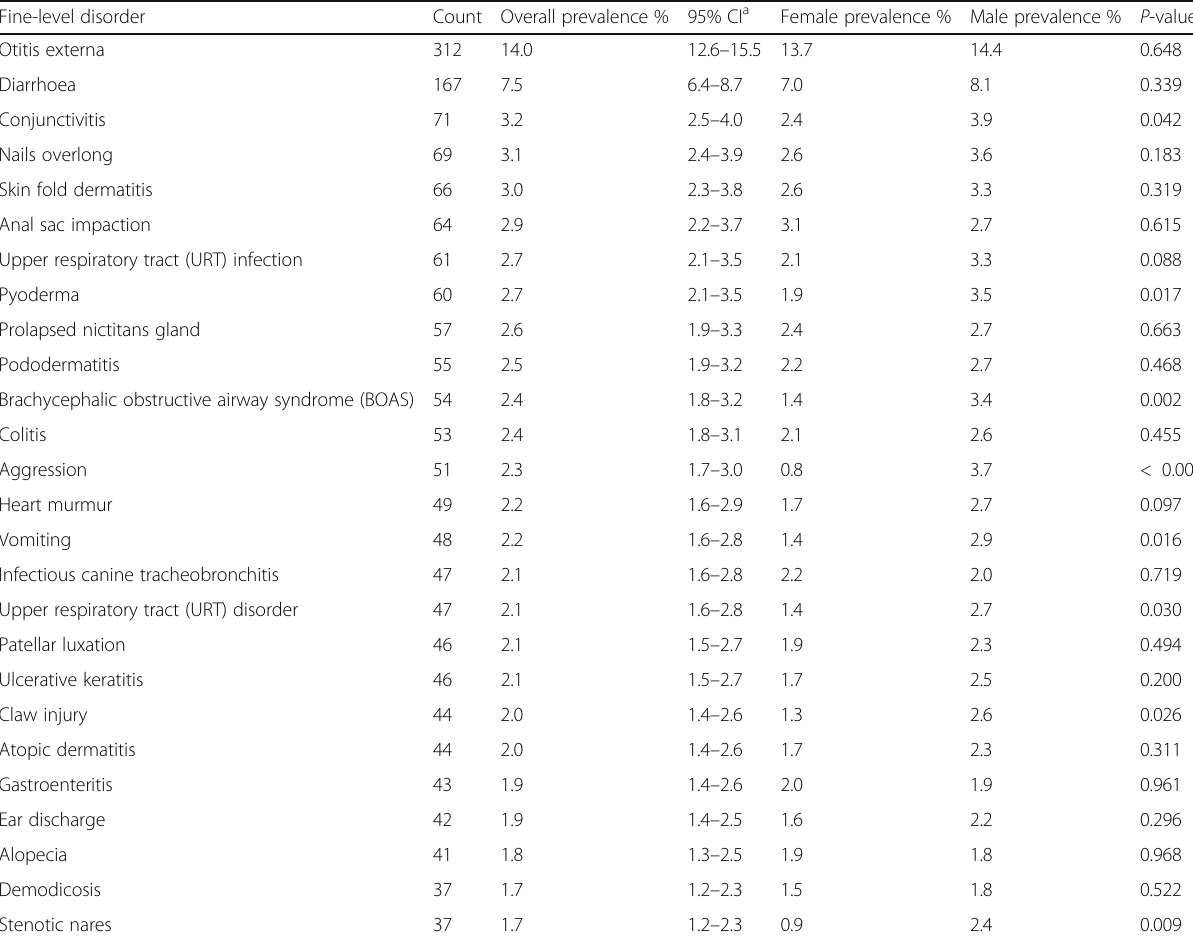
Table 3 Prevalence of the most common disorders at a fine-level of diagnostic precision recorded in French Bulldogs ( n = 2228) attending UK primary-care veterinary practices participating in the VetCompass ™ Programme from January 1st,